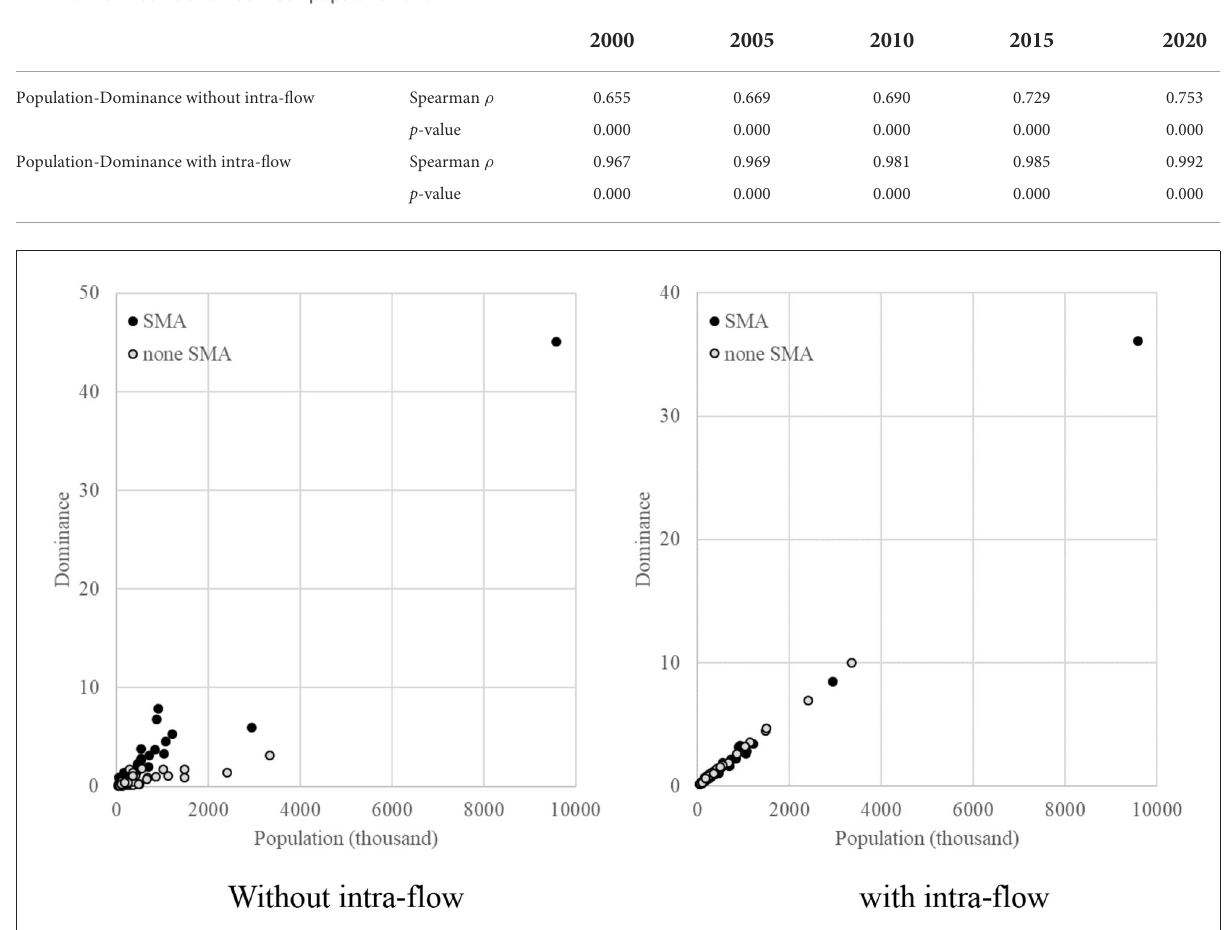
FIGURE6 Scatterplot between population sizes and DII